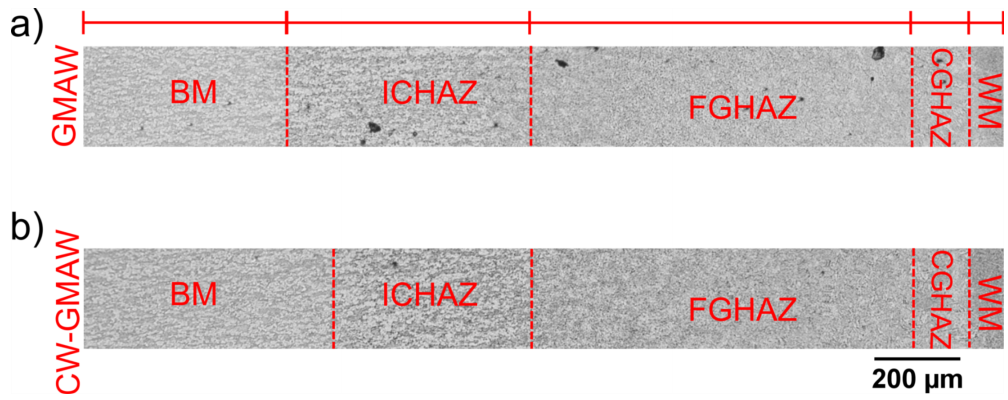
Figure 11. Heat affected zone (HAZ) width in the GMAW specimen showing the Weld metal (WM), Coarse grain heat affected zone (CGHAZ), Fine grain heat affected zone (FGHAZ), Intercritical heat affected zone (ICHAZ), and Base metal (BM): ( a ) standard GMAW; and ( b )